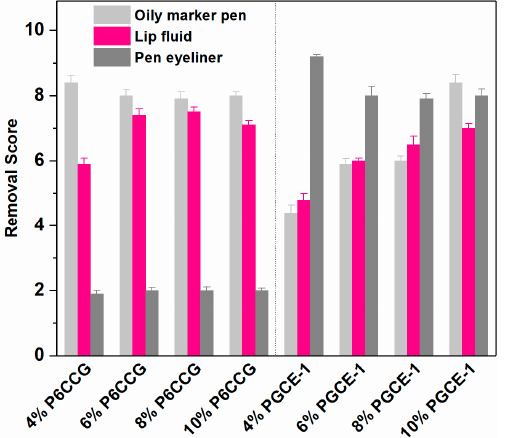
Figure 6. In vivo removal efficacies of P6CCG and PGCE ‐ 1 aqueous